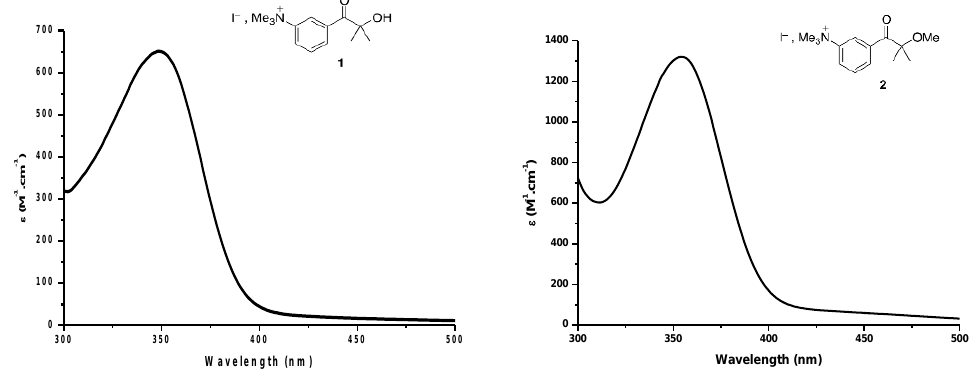
Figure 2. UV −v is absorption spectra of 1 and 2 in water.